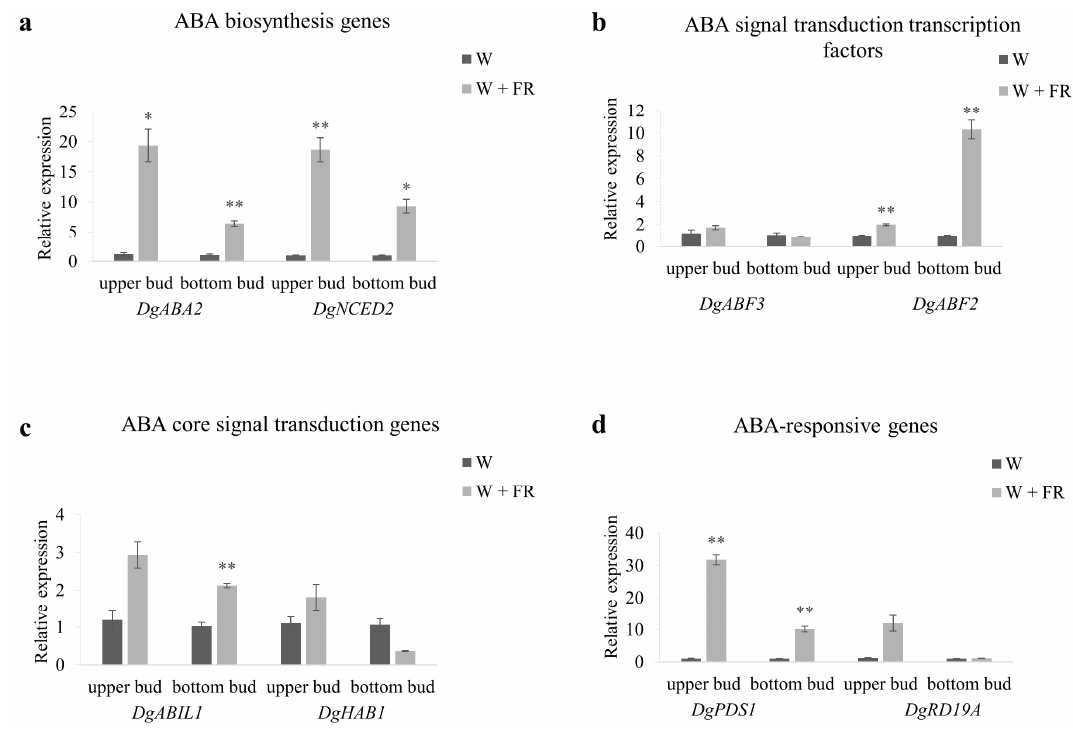
Figure 5. Expression profiles of ABA-related genes in upper bud and bottom bud of plants grown under high R:FR for 41 days (nearly 45 cm height) and then either maintained under high R:FR or provided with low R:FR for 8 h. ( a ) ABA biosynthesis genes DgABA2 and DgNCED2 ; ( b ) ABA signal transduction transcription factors DgABF3 and DgABF2 ; ( c ) ABA core signal transduction genes DgABIL1 and DgHAB1 ; ( d ) ABA-responsive genes DgPDS1 and DgRD19A . Data are mean ± SE of three biological replicates. Asterisks indicate significant differences between the treatment conditions W and W + FR for each position-bud at p < 0.05 (*) and p < 0.01 (**) level.